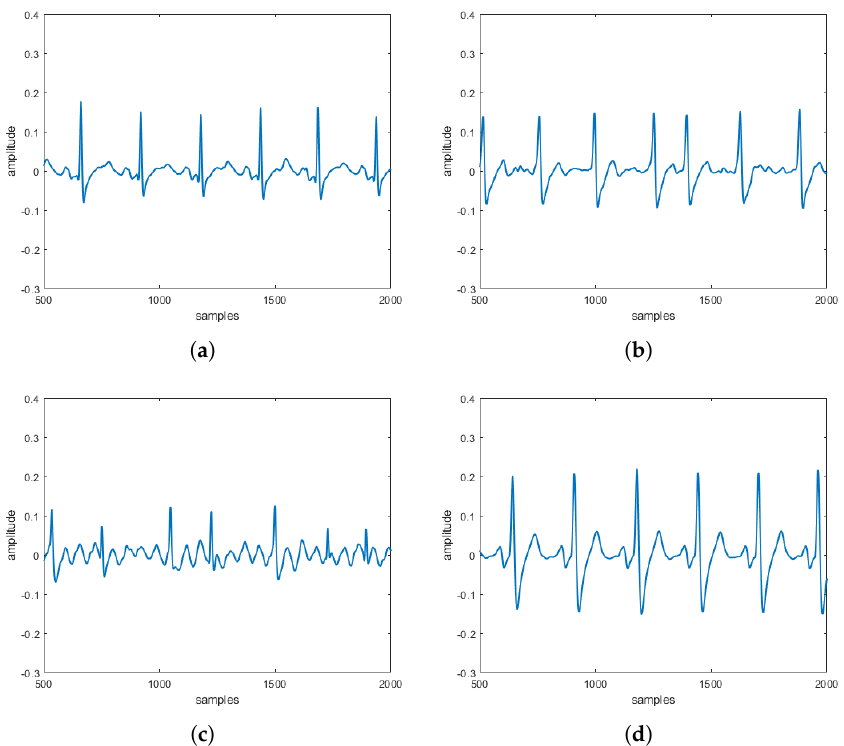
Figure 9. Case (b) of the proposed methodology: ( a ) normal sinus rhythm ( b ) atrial fibrillation ( c ) atrial flutter ( d ) premature ventricle contraction.